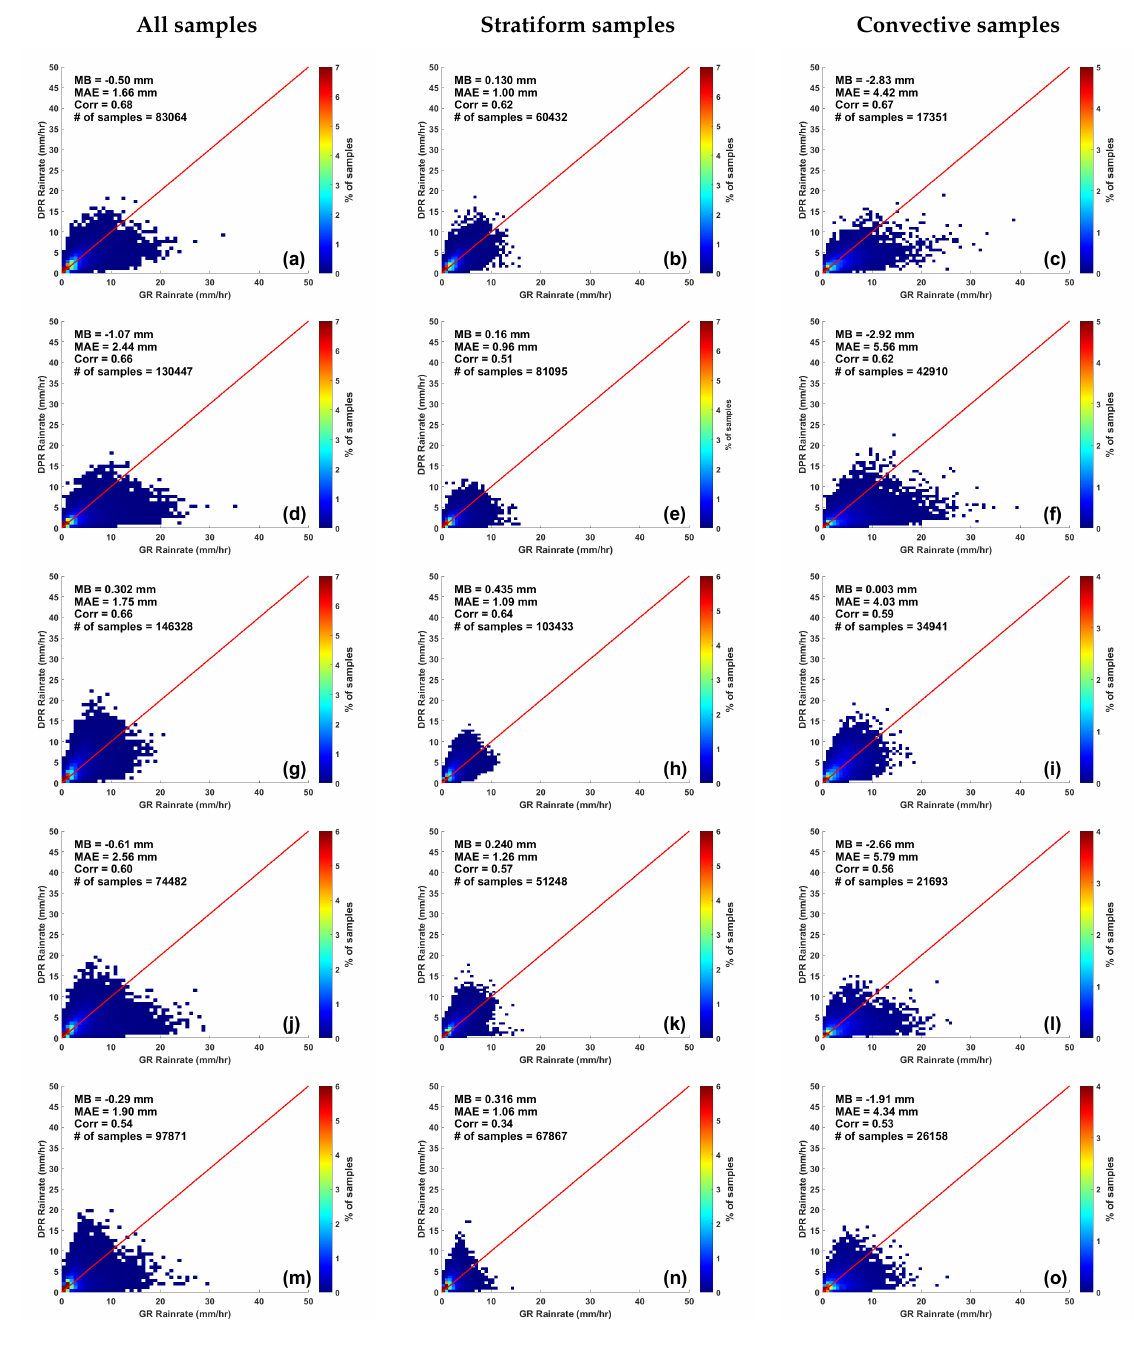
Figure 7. Scatter density plots of volume matched rainfall rate between GPM-DPR single frequency product and NEXRADs dual-pol product. Solid red line is 1:1 line. ( a – c ) KFWS radar; ( d – f ) KHGX radar; ( g – i ) KSHV radar; ( j – l ) KLIX radar; ( m – o ) KMLB